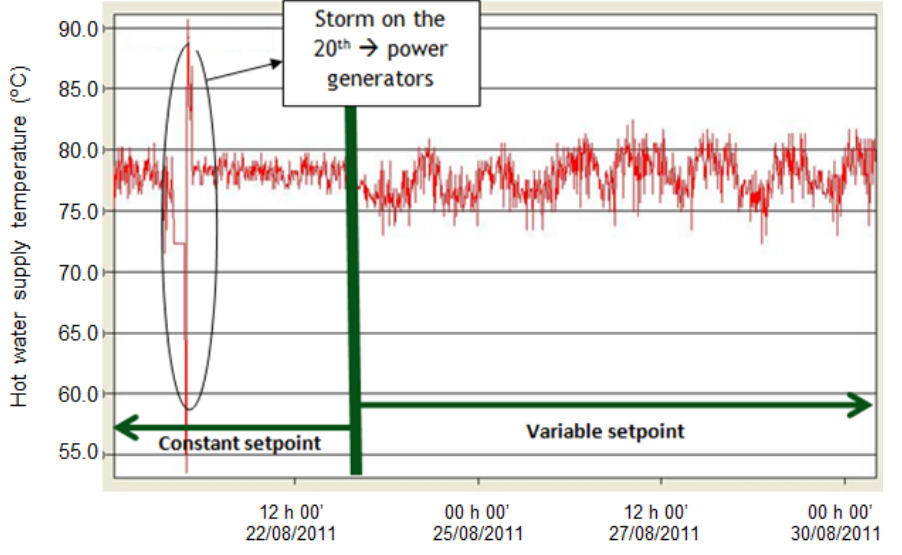
Figure 12. Boiler 5: Hot water supply temperature evolution (°C) implementing actions 1, 2, 3, and 4.